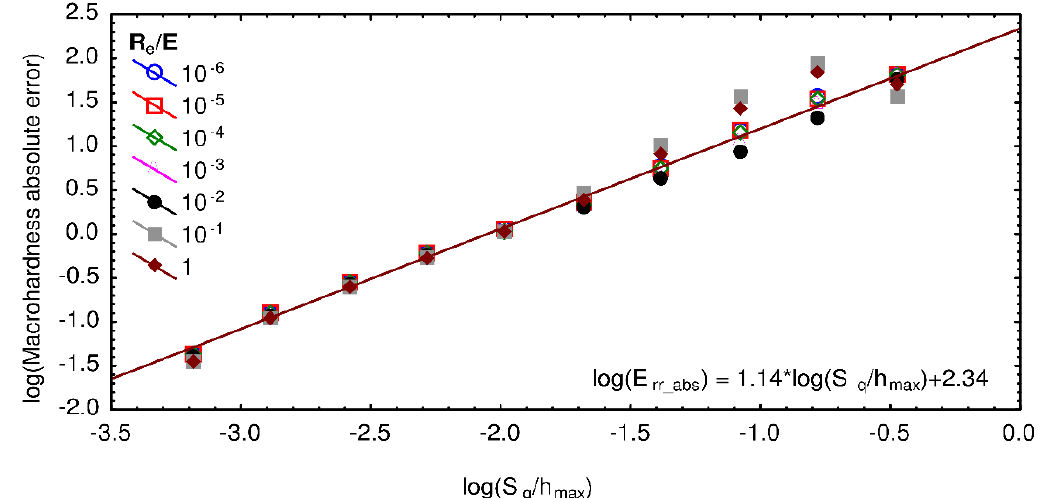
Figure 11. Logarithm of the macrohardness absolute error as a function of the logarithm of the ratio S q /h max for different values of R e /E ratio. The mesh size, wavelength, and fractal dimension were, respectively, set to 256 × 256, 32 µm, and 2.5.